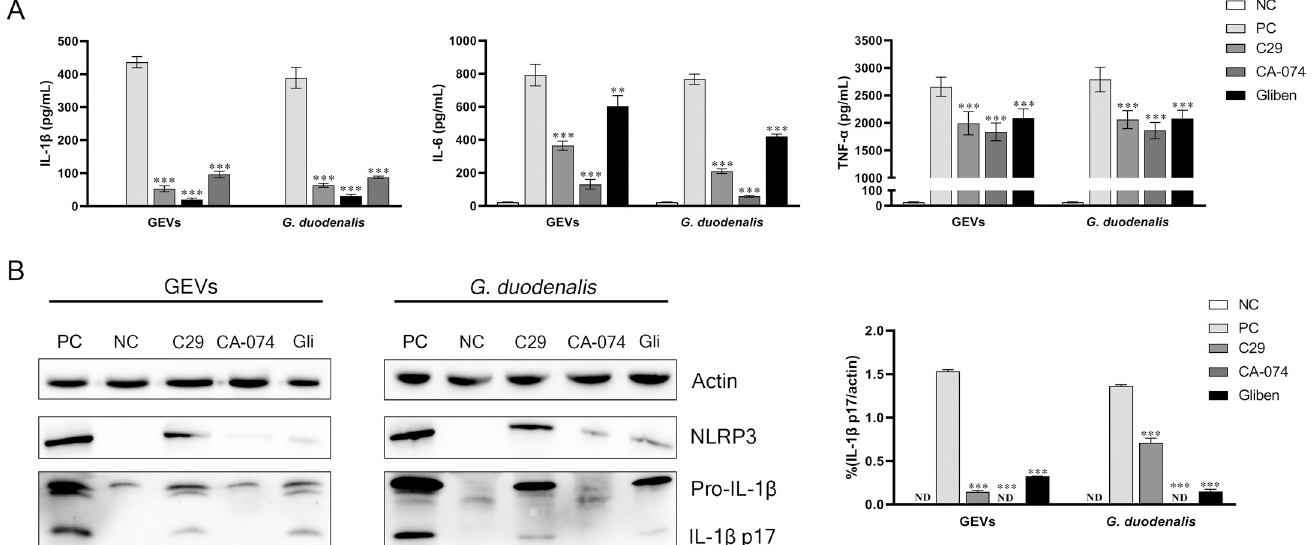
Fig 6. Roles of TLR2 and NLRP3 receptors in GEVs triggered inflammatory response. Murine peritoneal macrophages were pre-treated with 100 μ M C29, 100 μ M Glibenclimide, or 25 μ M CA-074 Me for 1 h and then added 25 μ g/mL GEVs or 1.5 × 10 6 parasites/mL G . duodenalis for 24 h. PBS-treated was used as negative control (NC) and GEVs or G . duodenalis -treated alone was used as positive control (PC). (A) Supernatants were collected and the protein expression levels of inflammatory cytokines, including IL-6, IL-1 β , and TNF- α were measured using ELISA assays. (B) Protein expression level of inflammatory cytokine IL-1 β in the culturing supernatants was detected using western blotting assay and densitometric percentage of IL-1 β and actin in GEVs and G . duodenalis were calculated. Results are representative of three independent experiments with three technical replicates and data are mean ± SEM. � p < 0.05, �� p < 0.01 or ��� p < 0.001 vs. PC of GEVs group or G . duodenalis treated